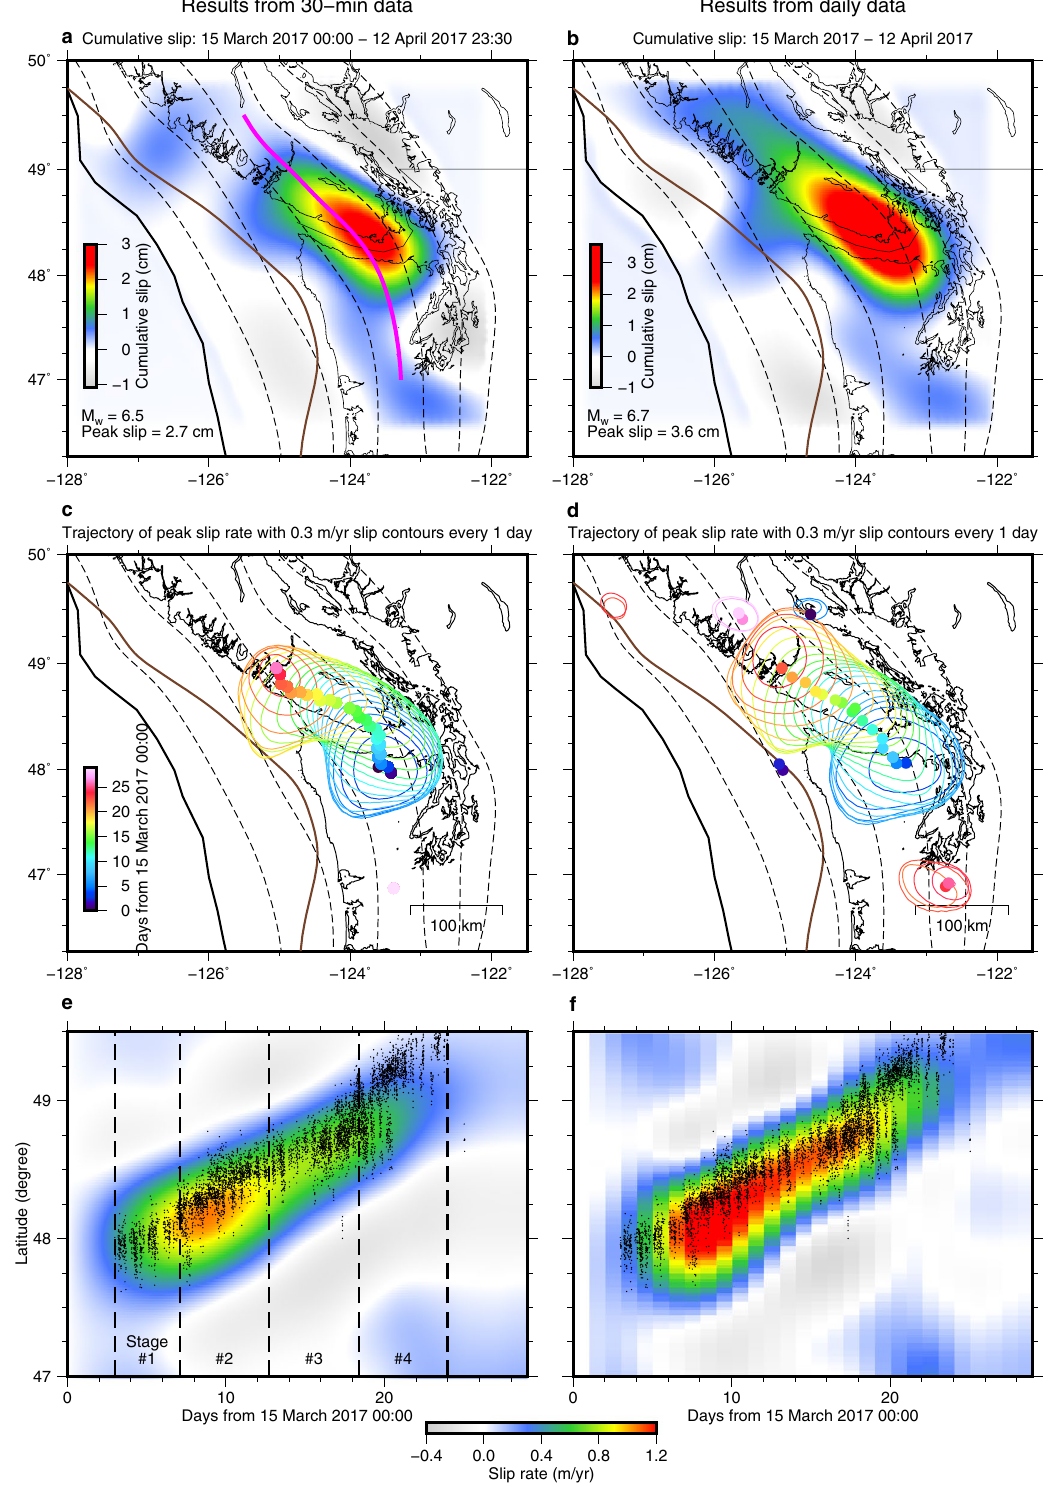
Figure 4. Comparison of inversion results using 30-min and daily data. Left ( a , c , e ) and right ( b , d , f ) columns indicate results from inversions of 30-min kinematic and daily static GPS positions, respectively. ( a , b ) Cumulative slip of the March to April 2017 SSE. The thick purple curve in panel ( a ) indicates the location of the profile for ( e , f ). ( c , d ) Collection of slip rate contours of 0.3 m/yr every day is color-coded with time. Colour- coded dots indicate the trajectory of peak slip rate location. The colour of trajectory and contours indicates the time. ( e , f ) Temporal evolution of slip rate along a profile along 35-km slab interface depth [the purple curve in ( a )] with tremors (dots), epicentres of which are located above the 30- to 40-km depths slab